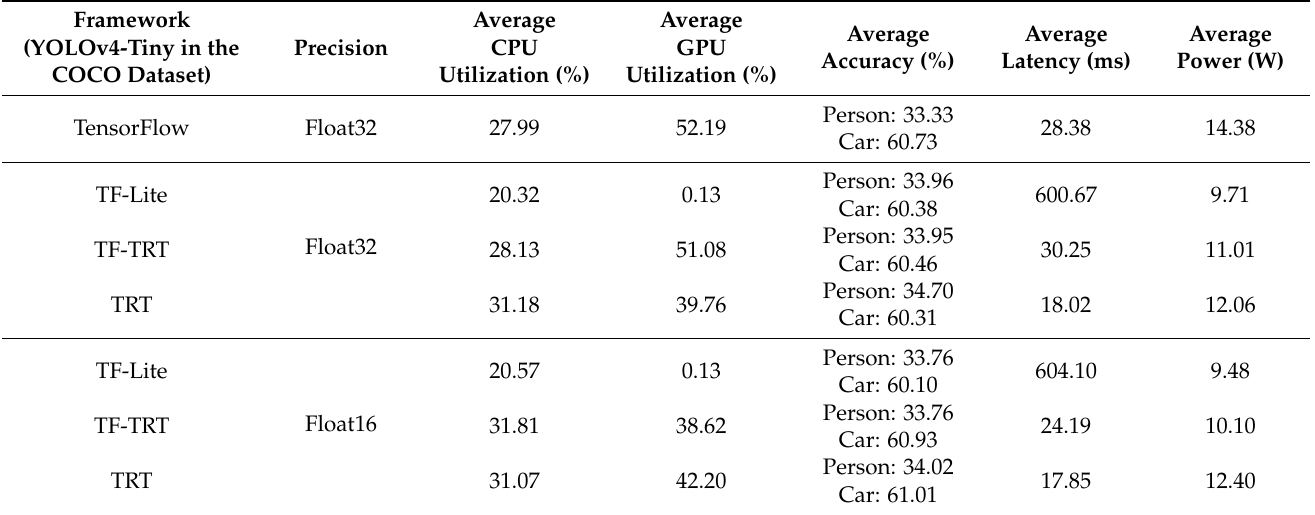
Table 3. Comparative analysis of YOLOv4-Tiny.weights’s inference performance in the COCO